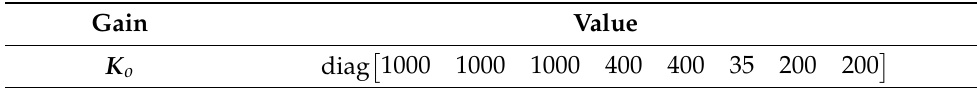
Table 2. Momentum observer gain.